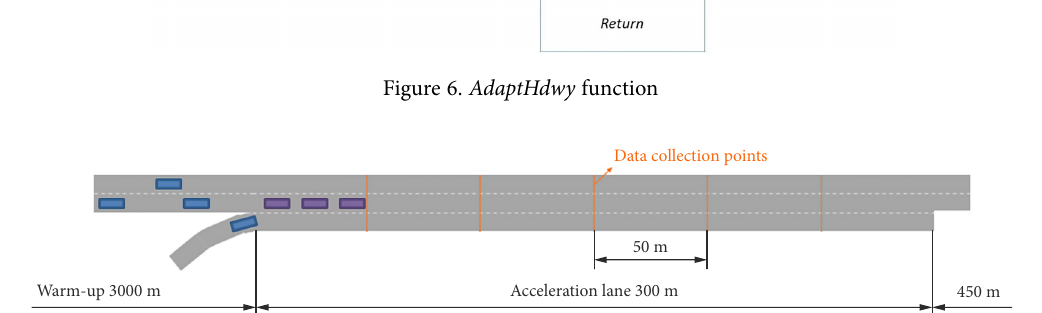
Figure 7. Modelling layout – adapted from research by Aleccia